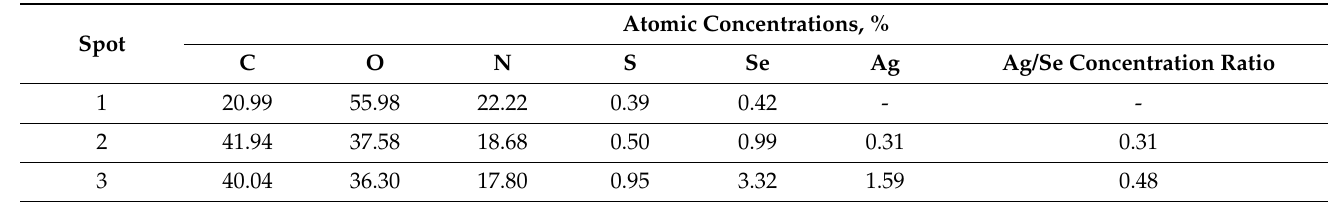
Table 4. Chemical composition from each fractional layer (spot 1, spot 2, and spot 3, as marked in Figure 3) of the Ag–Se-12/nylon nanocomposite obtained by EDS.